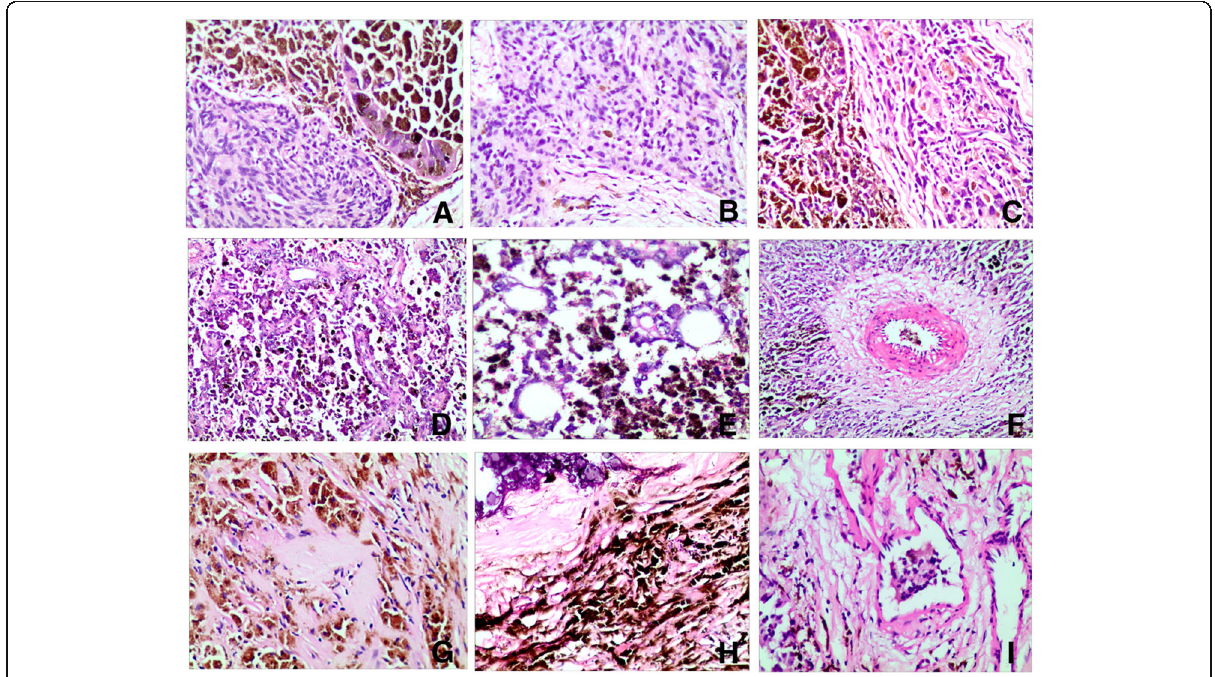
Fig. 1 Morphological characteristics of melanin-producing MTC. H&E staining evidenced that the tumor cell with abundant black or brown melanin ( a ), minimal melanin ( b ). Melanin was found in the cytoplasm of the tumor cells or the extracellular matrix ( c ). The tumor displayed different structural morphologies: papillary (1 d ), microcapsule (1 e ), and angioneoplasm-like (1 f ). Part of the tumor cells were separated by amyloid-like material (1 g ). Psammoma bodies (1 h ) and tumor embolus (1I) was observed in certain visual fields, (hematoxylin-eosin staining, Magnification ×